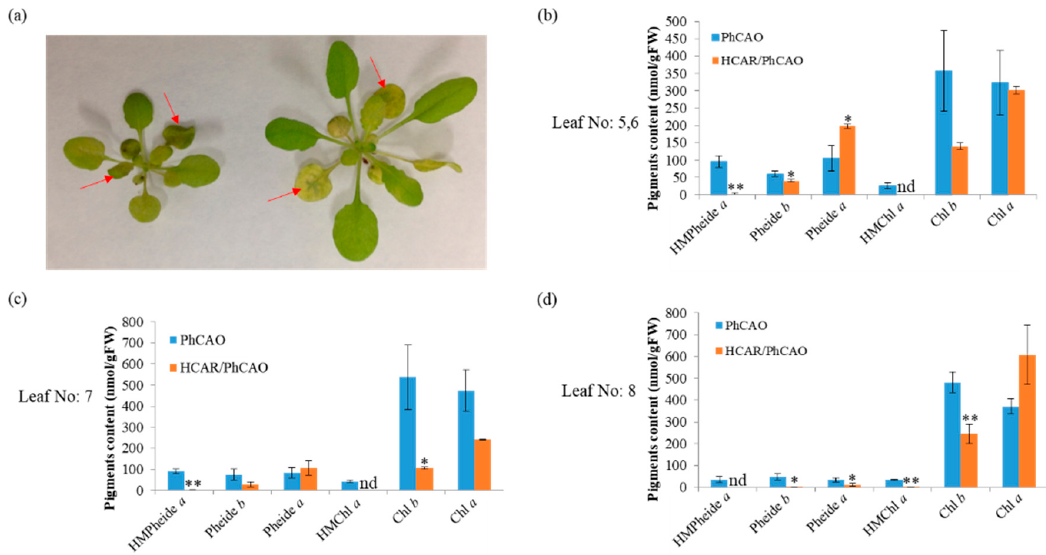
Figure 4. Analysis of the senescence phenotype and the accumulation of Chl and its degradation intermediate molecules after dark-induced senescence. For this, 4-week-old PhCAO and HCAR/PhCAO plants were incubated in darkness for 6 days. ( a ) Overexpressing HCAR alleviates the non-PCD symptoms in PhCAO during dark-induced senescence. Red arrows indicate the senescence symptoms of No. 5 and 6 leaves of plants, which were put in darkness for 6 days. ( b – d ) The pigment contents of dark-induced senescent leaves 5-6, 7 and 8, respectively. Pigment measurements were performed on three biological replicates. Error bars indicate the SDs of the biological replicates. Asterisks indicate significant difference compared to PhCAO (Student’s t -test, * p < 0.05, ** p < 0.01). nd indicates not detected.